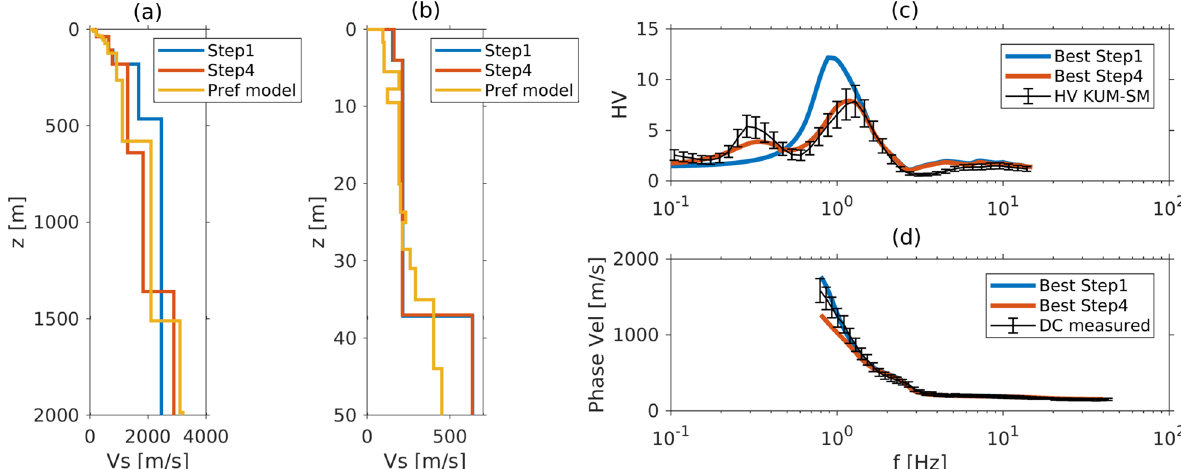
Fig. 6 Velocity model. a Shear-wave velocity model for KUMA site from the inversion of the broadband fundamental mode dispersion curve (Fig. 5) for Step 1 (blue) and for Step (red) compared to the preferred model (yellow) provided by the ESG6 organizing committee for comparison. In Step 4 the HVSR data were used. b Zoom of the top 50 m of the shear-wave velocity model. c Predicted HVSR curves for the Step 1 (blue) and Step 4 (red) models, plus the HSVR data (black). d Predicted broadband fundamental mode dispersion curves, same color scheme as